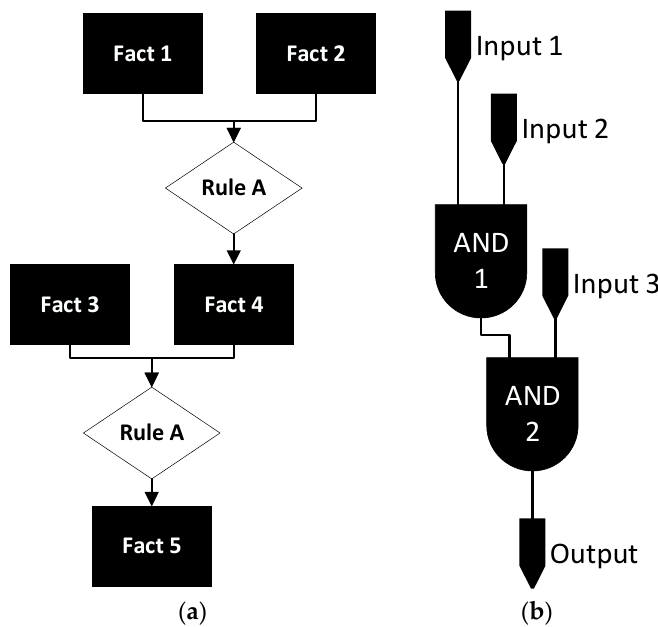
Figure 6. Expert system implementations: ( a ) software, left and ( b ) hardware,